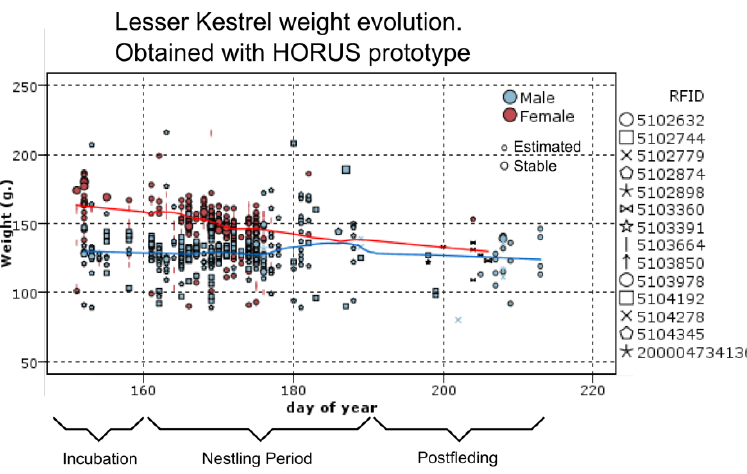
Figure 8. Weight evolution obtained with the proposed system from different